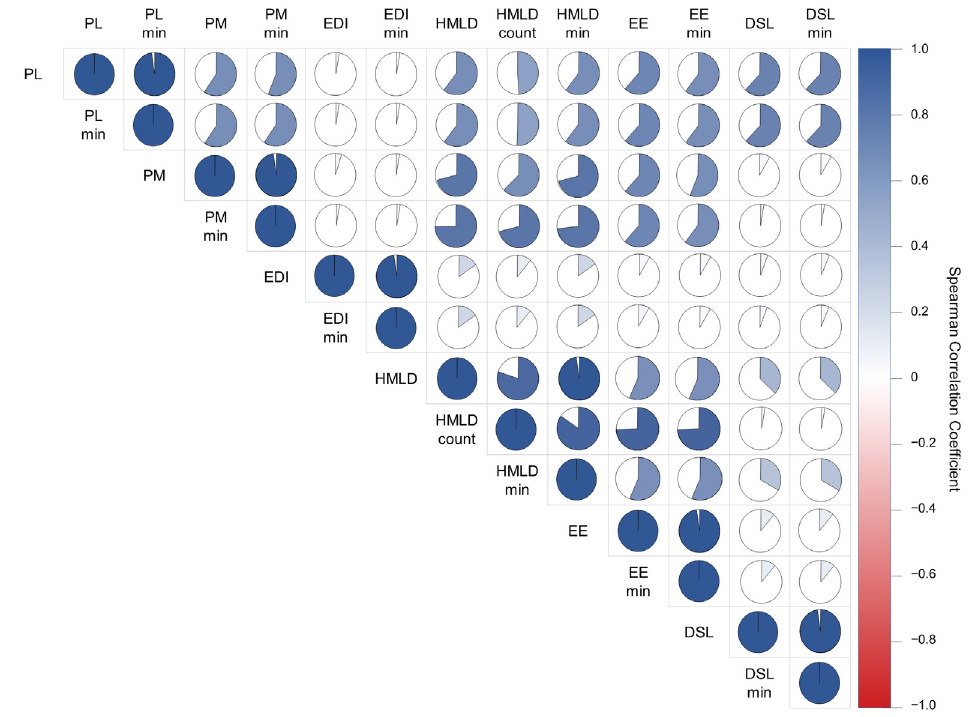
Figure 2. Pairwise Spearman correlation of the external load variables from official matches data in substitute players.